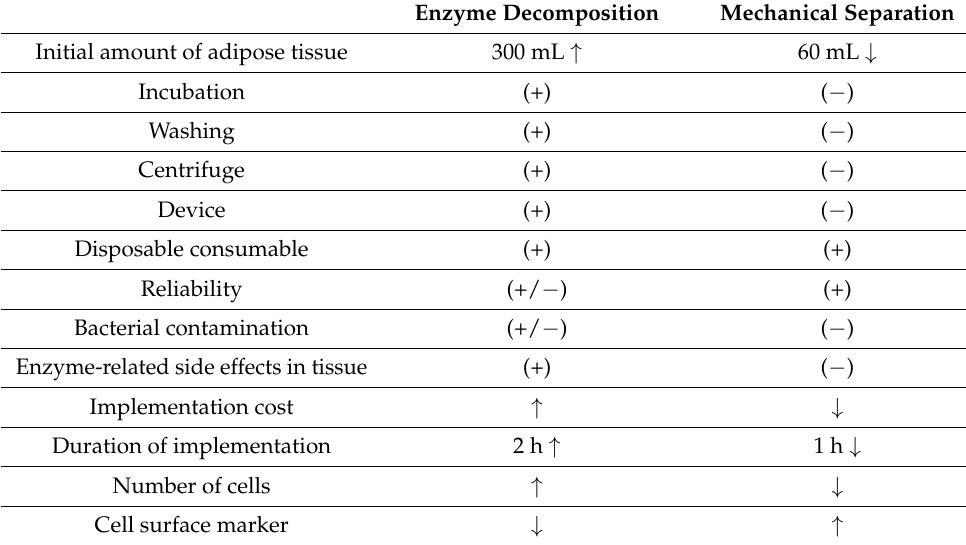
Table 3. Advantages and Disadvantages of Enzymatic and Mechanical Stromal Vascular Fraction Separation